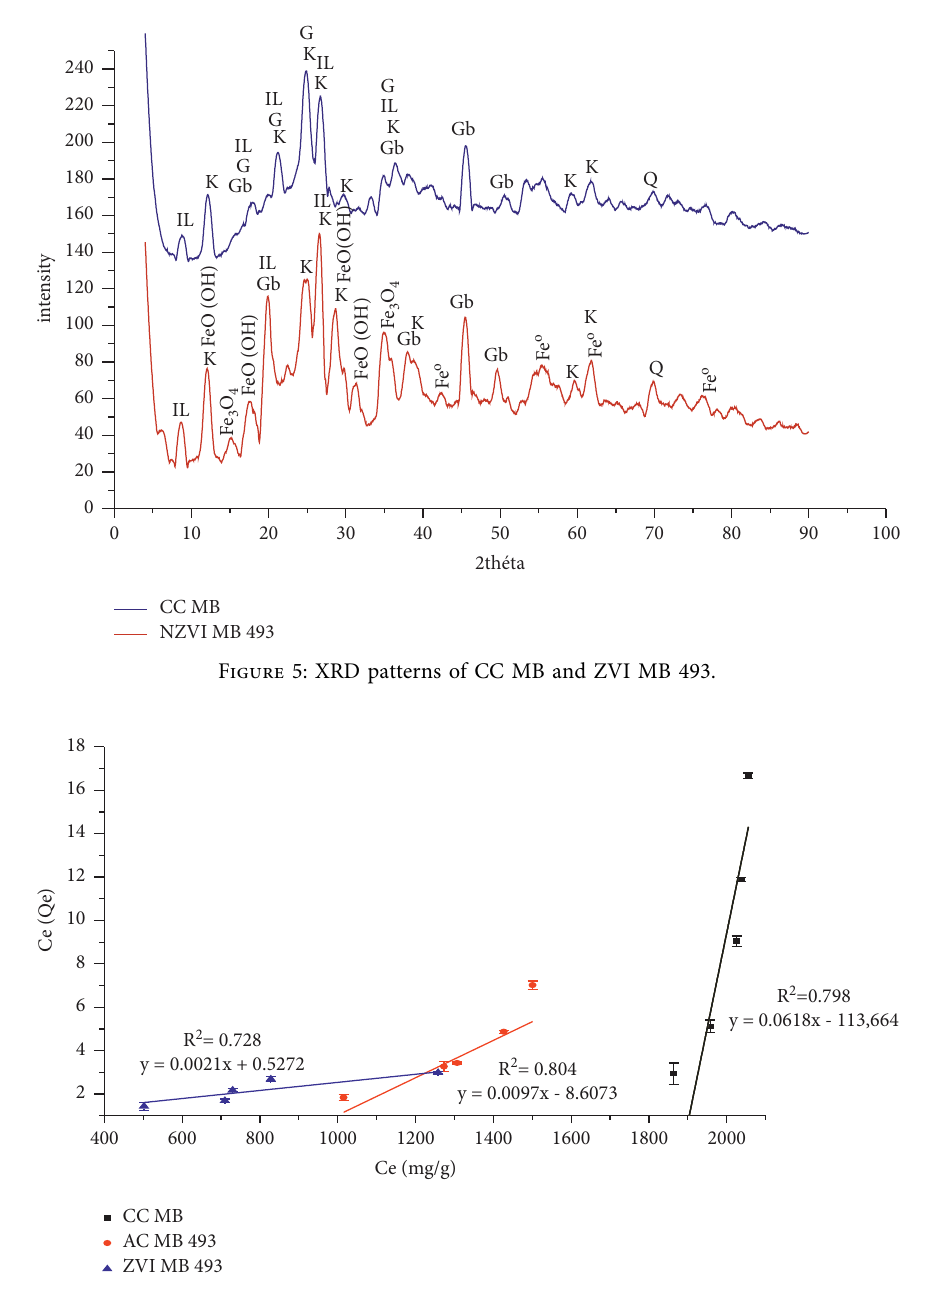
Figure 6: Langmuir adsorption isotherm for removal of β -carotene onto CC MB, AC MB 493, and ZVI MB 493 at 75 °